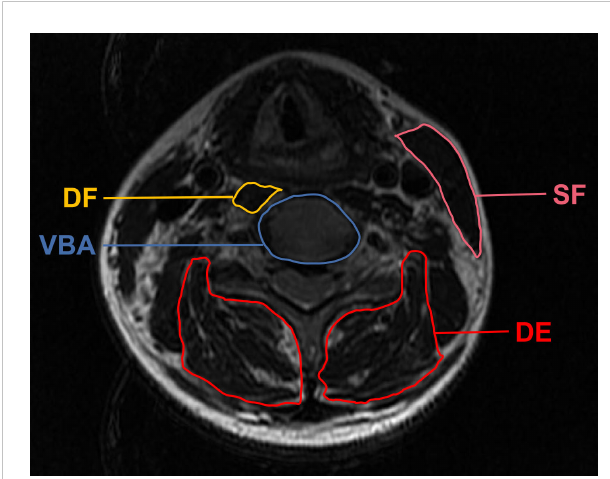
FIGURE 3 Demonstrative axial T2 magnetic resonance imaging sections of the regions of interest applied in measuring the cross-sectional area. SF, super fi cial fl exor; DF, deep fl exor; DE, deep extensor; VBA, vertebral body area.